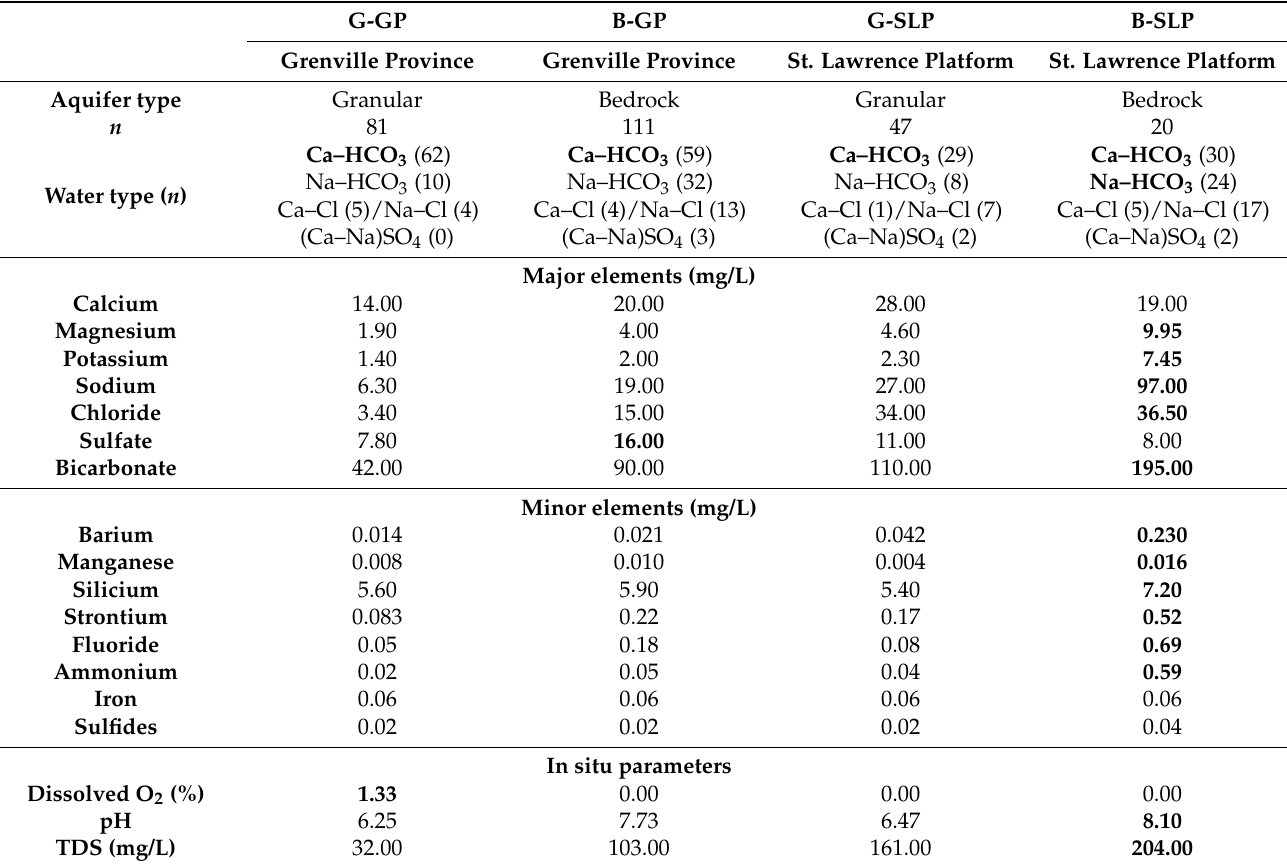
Table 2. The median concentration of major and minor elements and in situ parameters. Major and minor elements with the highest median concentrations are in